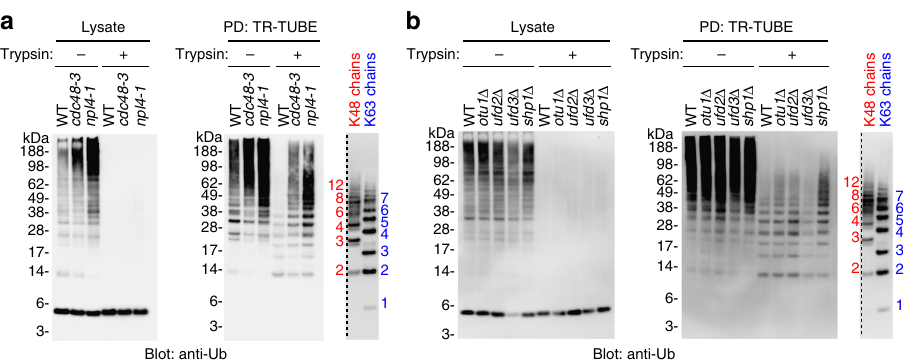
Fig. 5 Ubiquitin chain elongation in npl4-1 mutant. a , b Ub-ProT analysis of Cdc48 cofactor mutant cells. Soluble lysate from wild-type (WT), npl4 mutant cells (npl4-1 ), otu1 Δ , ufd2 Δ , ufd3 Δ , or shp1 Δ cells were subjected to Ub-ProT analysis. Free ubiquitin chains were used as